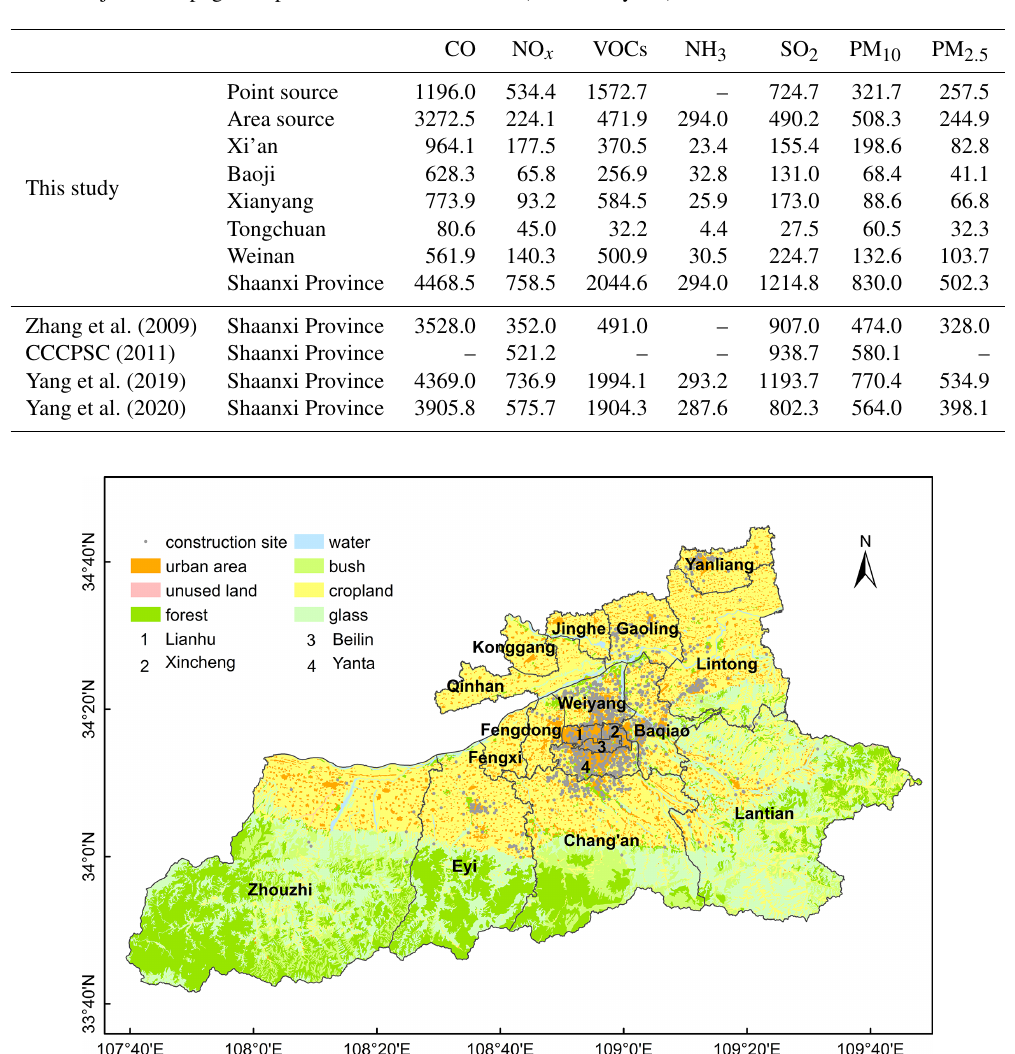
Figure 5. Spatial distribution of construction sites in Xi’an. Grey dots indicate the construction sites. The base map shows the types of land use (Xiao et al.,